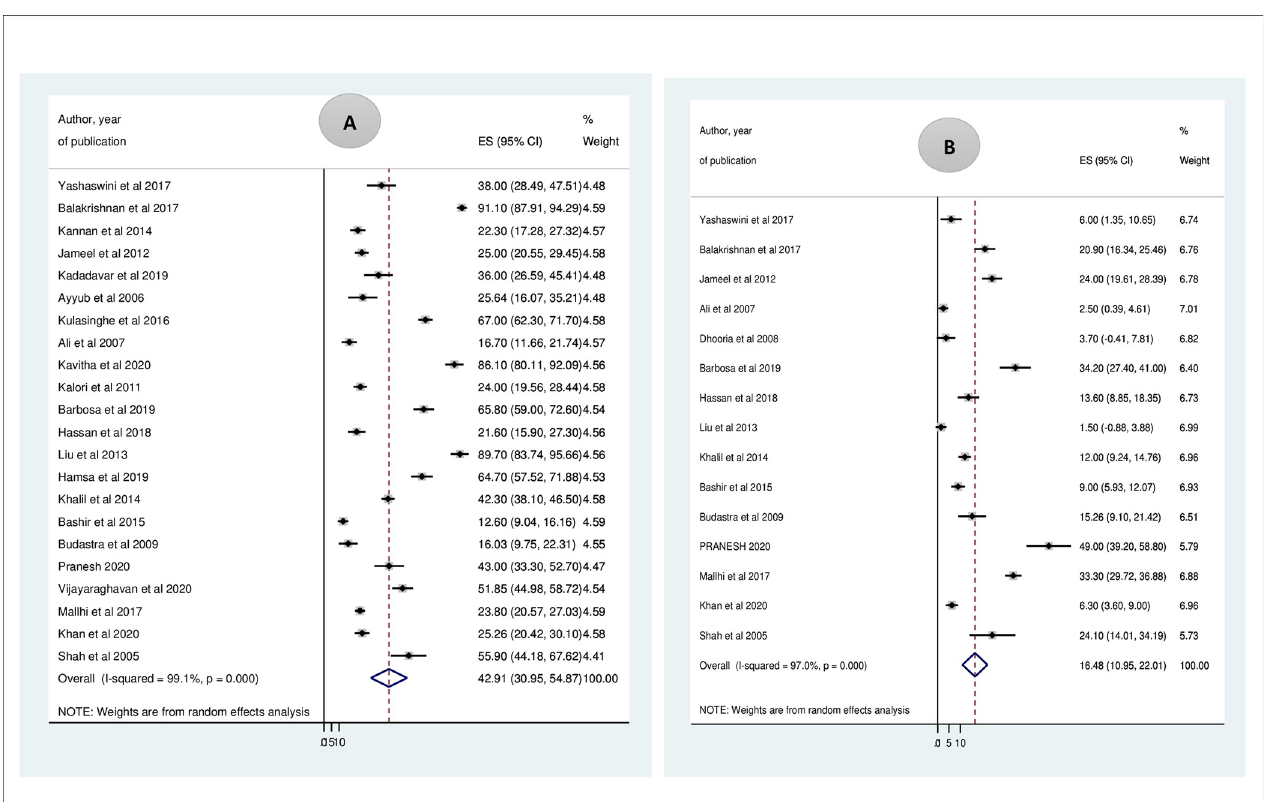
Fig 2. Forest plot displaying A. The magnitude of prolonged APTT among dengue fever patients B. The magnitude of prolonged PT among dengue fever patients.